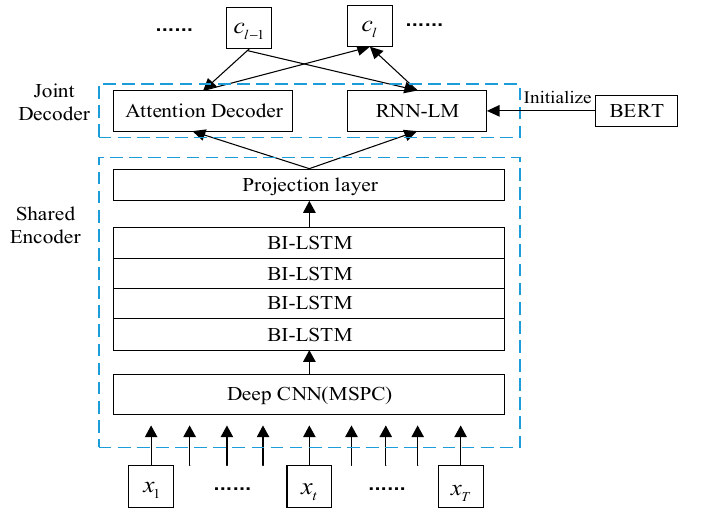
Figure 6. Illustration of the end-to-end framework based on hybrid CTC/attention that we use. The shared encoder is simultaneously trained by the CTC and the attention model objectives and mainly transforms the input sequence x into a high-level representation h . The joint decoder predicts an output label sequence through the attention decoder and RNN-LM. Context vector c l is calculated using Equation (8).